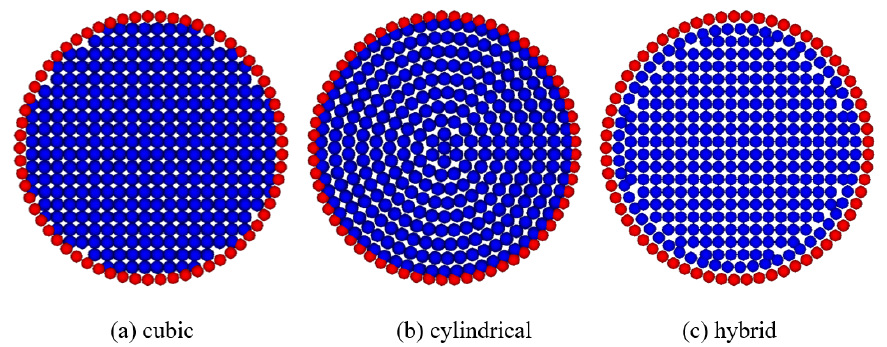
Figure 11. Initial particle arrangement for different assumptions.